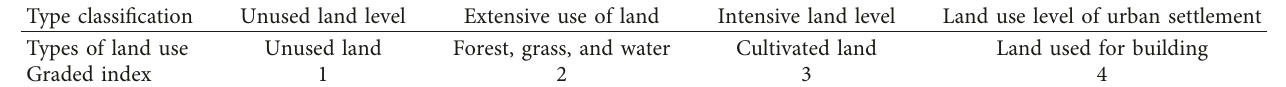
Table 1: Grading index table of land use